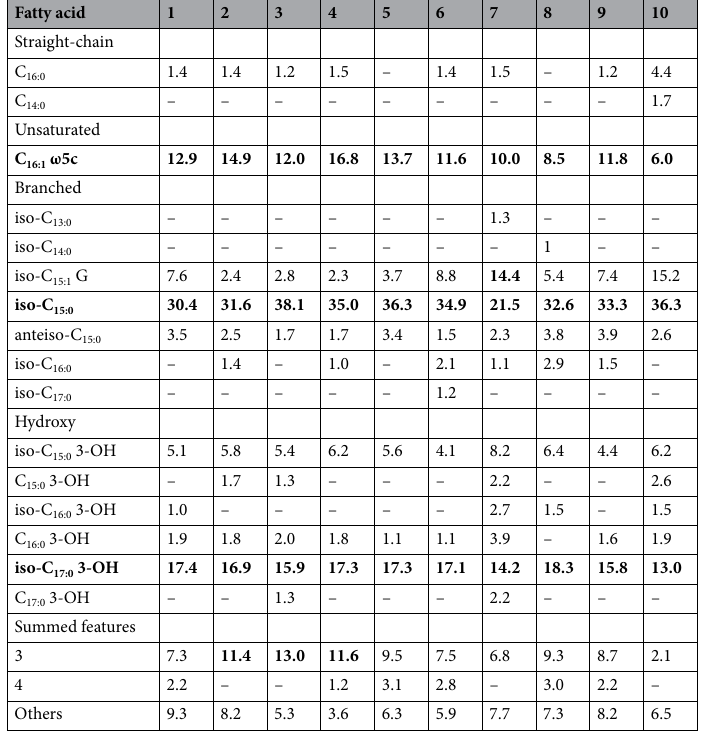
Table 3. Composition (%) of the cellular fatty acid of three novel strains SS9-22 T , W9P-11 T , SW1-E11 T and other species in genus Fulvivirga . Taxa: 1, SS9-22 T ; 2, W9P-11 T ; 3, SW1-E11 T ; 4, F. sediminis 2943 T ; 5, F. imtechensis JCM 17390 T ; 6, F. aurantia KCTC 82638 T ; 7, F. kasyanovii KCTC 12832 T ; 8, F. marina 29W222 T ; 9, F. lutimaris KCTC 42720 T ; 10, F. lutea S481 T . Numbers indicate the percentages of the fatty acids. -, not